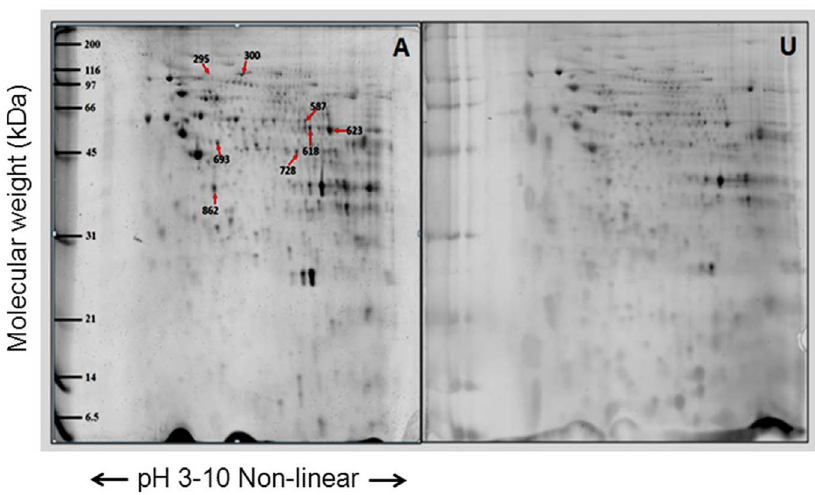
Figure 5. Representative proteome map of differentially expressed proteins from the mitochondrial fractions of fibroblasts from (A) LHON cases (n=7) and (U) unaffected LHON individuals (n=3). Equal amounts of proteins (100 m g) from each sample were resolved by 2-DE. The numbers indicate the spot IDs of proteins whose expression levels differ significantly between the LHON cases and their unaffected relatives.